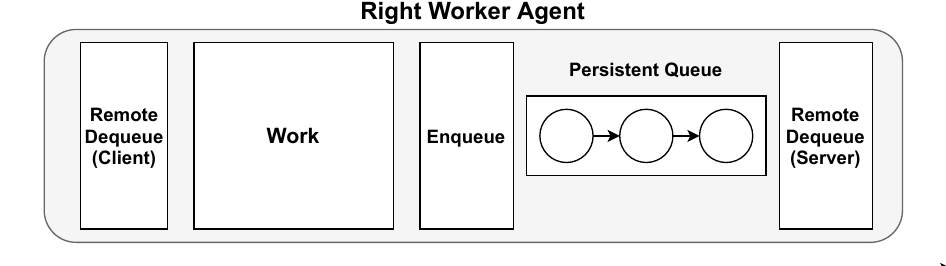
Figure 6. Right worker agent. A worker agent that dequeues messages from a remote queue before the analysis process, but enqueues the result on a local queue.